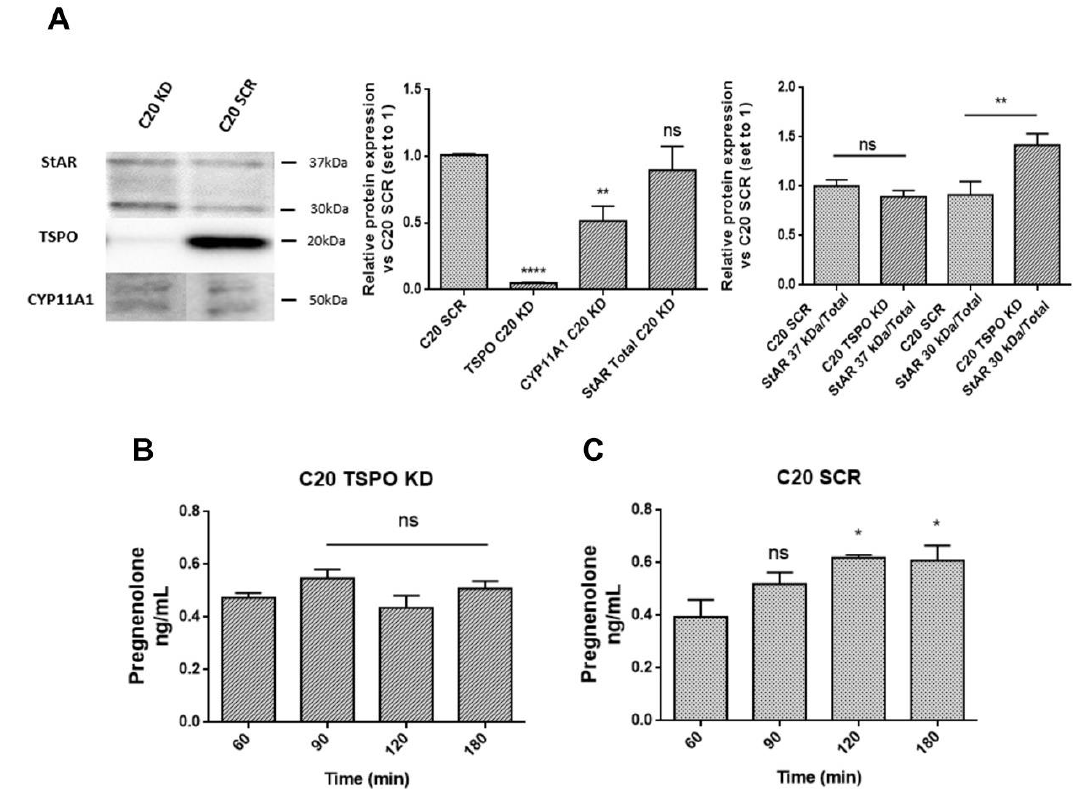
Figure 5. TSPO silencing reduced the steroidogenic ability of the microglial C20 cell line. ( A ) Representative figure of the transduceosome/metabolon protein expression (Western blot) and relative densitometric analysis in C20 TSPO KD and SCR control cells. In addition to the expected low level of TSPO, CYP11A1 expression turned out to be reduced in C20 TSPO KD cells; no differences were found in the total or cytosolic StAR expression. However, the mitochondrial form of StAR seemed to be more expressed as a result of a possible compensatory mechanism due to the TSPO knock-down. The bars show the outcomes of the densitometric analysis performed for three independent experiments; results are reported as fold changes ± SEMs of the protein expression vs. C20 SCR cells. The significance of the differences was determined by one-way ANOVA, which was followed by Bonferroni’s post-test: ** p < 0.01, **** p < 0.0001 vs. C20 SCR cells. ( B , C ) Kinetic analysis of pregnenolone production in C20 TSPO KD and SCR cells. The TSPO knock-down did not completely abolish the production of pregnenolone; however, no differences in its accumulation at the subsequent time points were observed. On the contrary, a statistically significant accumulation of pregnenolone after 120 and 180 min was observed in C20 SCR cells. Data are presented as means ± SEMs of three independent experiments. Statistical analysis was determined by one-way ANOVA followed by Bonferroni’s post-test: * p < 0.05 vs. 60